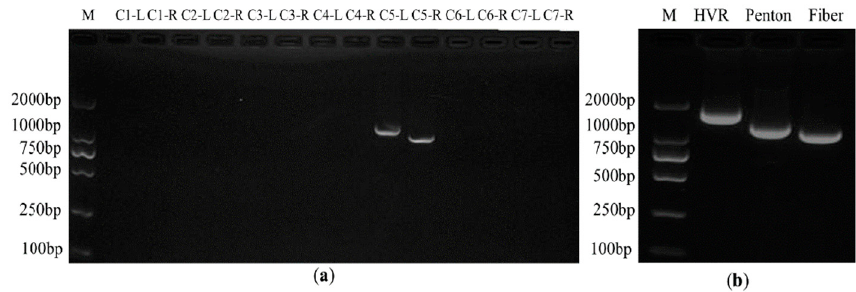
Figure 2. Identification of infectious clones of PBRAdV14 by PCR. ( a ) PCR screening with primers targeting the left ligation region. L: PCR with pBR-ad14-1-For and pBR-ad14-1-Rev; R: PCR with pBR-ad14-2-For and pBR-ad14-2-Rev. Seven clones were screened first, C1, C2, C3, C4, C5, C6, C7; ( b ) PCR screening with primers targeting the three major capsid genes: HVR, Fiber and Penton base. Length of positive PCR product is 1685 bp for HVR, 1253 bp for Penton base and 1153 bp for Fiber.